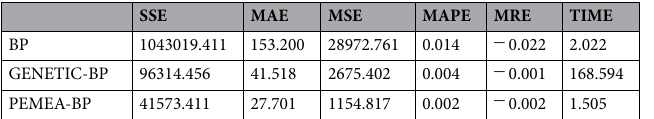
Table 4. Fitting accuracy